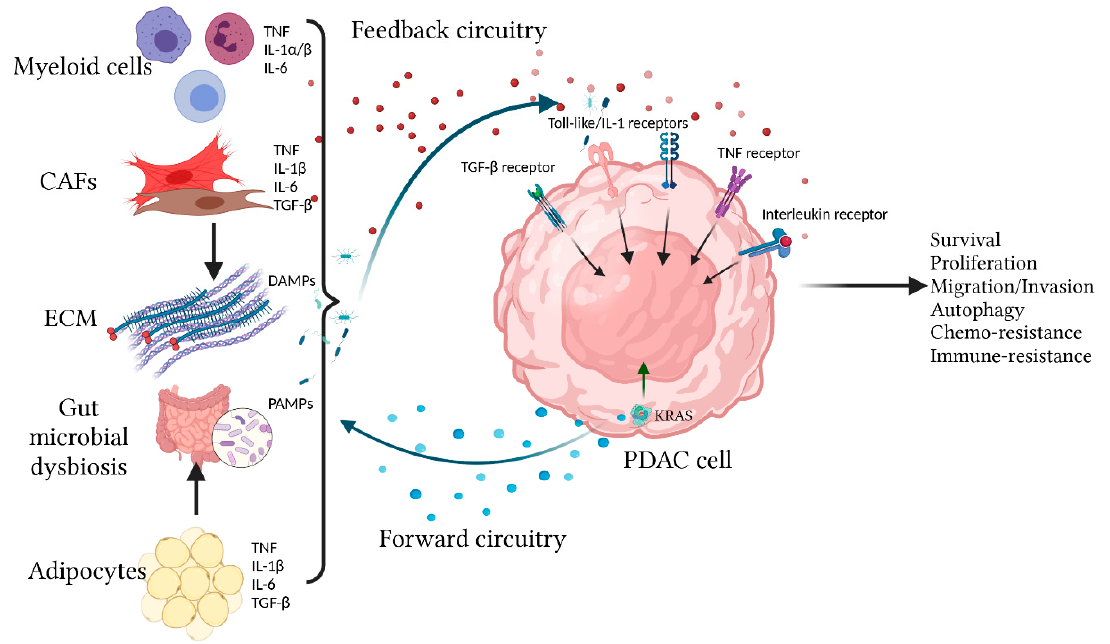
Figure 1. Overview of the bi-directional onco-inflammatory network between PDAC cells and surrounding cells. Oncogenic KRAS signaling in transformed PDAC cells drives effector cascades leading to secretion of inflammatory cytokines/chemokines such as IL-1 α / β , IL-6, and CXCL1 to the TME. These secreted factors not only have autocrine signaling functions but also have paracrine effects by recruiting and reprogramming the surrounding non-neoplastic cells, causing them to secrete more cytokines/chemokines into the TME. These cytokines/chemokines provide